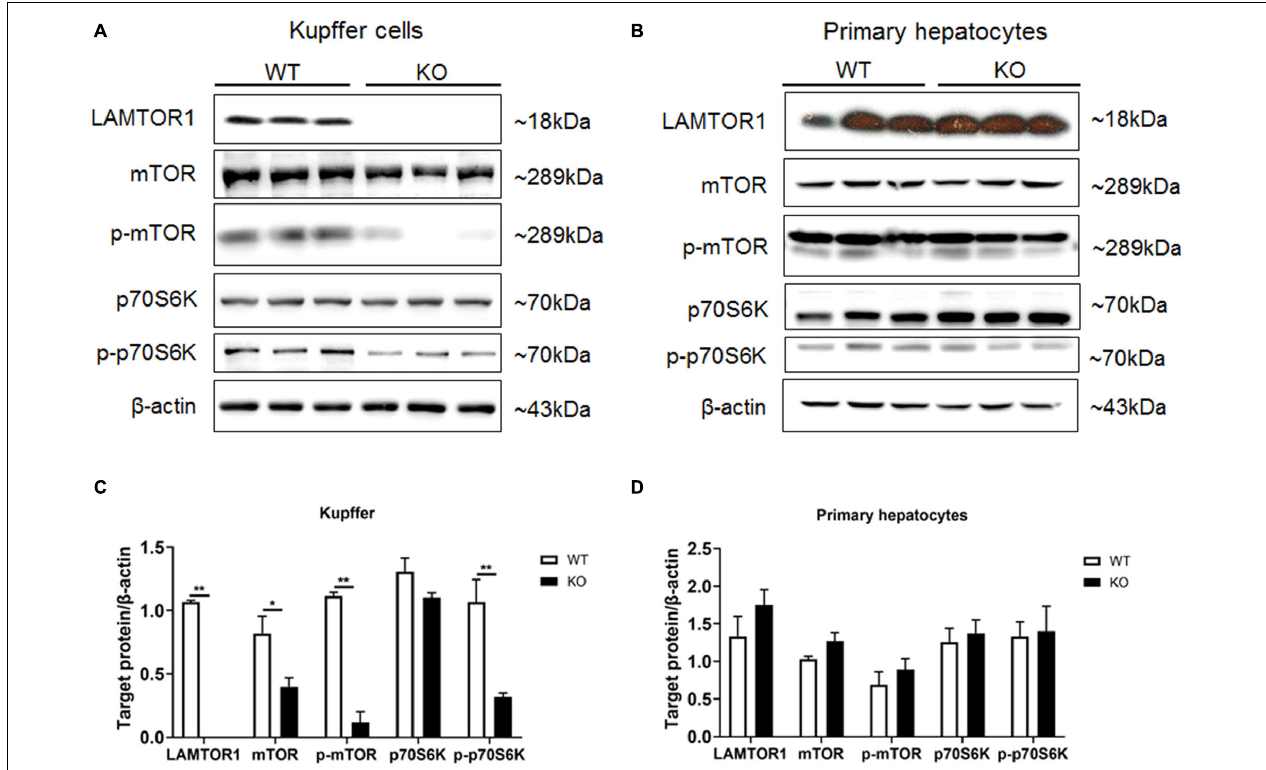
FIGURE 1 | LAMTOR1 MKO mice were successfully generated. (A,B) Protein expression of LAMTOR1/mTORC1/p70S6K in Kupffer cells (A) and primary hepatocytes (B) analyzed by western blotting. (C,D) Quantification of the protein expression of LAMTOR1/mTORC1/p70S6K in Kupffer cells (C) and primary hepatocytes (D) . n = 4–6. * P < 0 . 05 vs. WT; ** P < 0 . 01 vs. WT. KO, myeloid-specific knockout mice; WT,